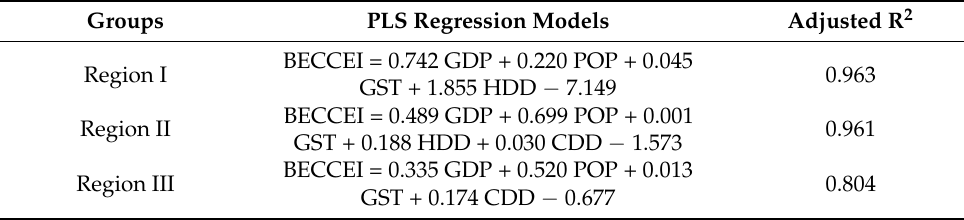
Table 1. PLS regression models constructed for each region (BECCE intensity labeled BECCEI).